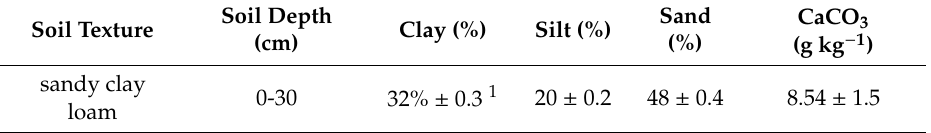
Table 1. Selected soil properties and the particle size distribution of the soil in the experimental field.